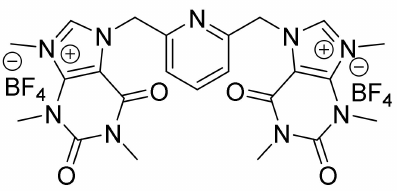
Scheme 1. Schematic representation of the tridentate pyridine-based